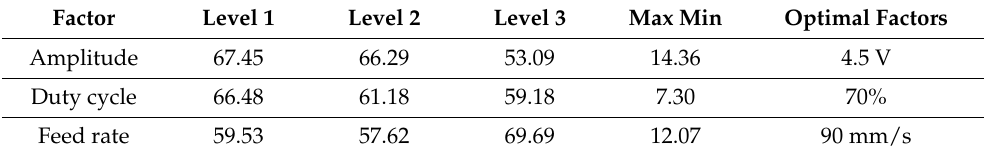
Table 6. Optimal combination of